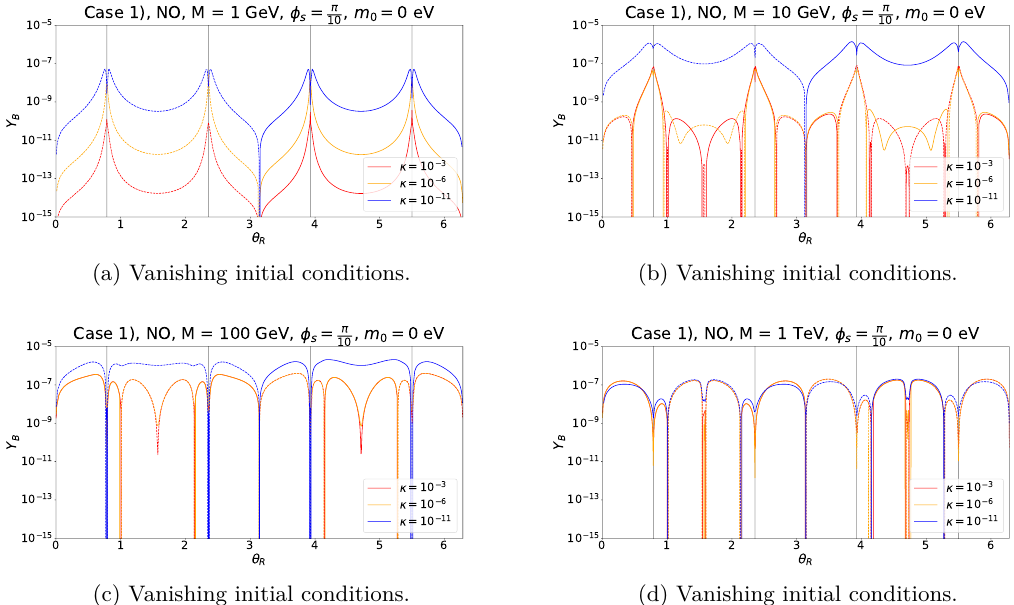
Figure 8 . Case 1) Y B as function of the angle θ R for four different values of the Majorana mass, M = 1 GeV (upper left plot), M = 10 GeV (upper right plot), M = 100 GeV (lower left plot) and M = 1 TeV (lower right plot), and different values of κ , κ ∈ { 10 − 3 , 10 − 6 , 10 − 11 } . Both negative (dashed lines) as well as positive (continuous lines) values of the BAU are represented. The value of and light neutrino masses follow strong NO. The vertical grey lines correspond φ s is fixed to φ s = π 10 to regions, in which the criterion, given in eq. (3.69), is not